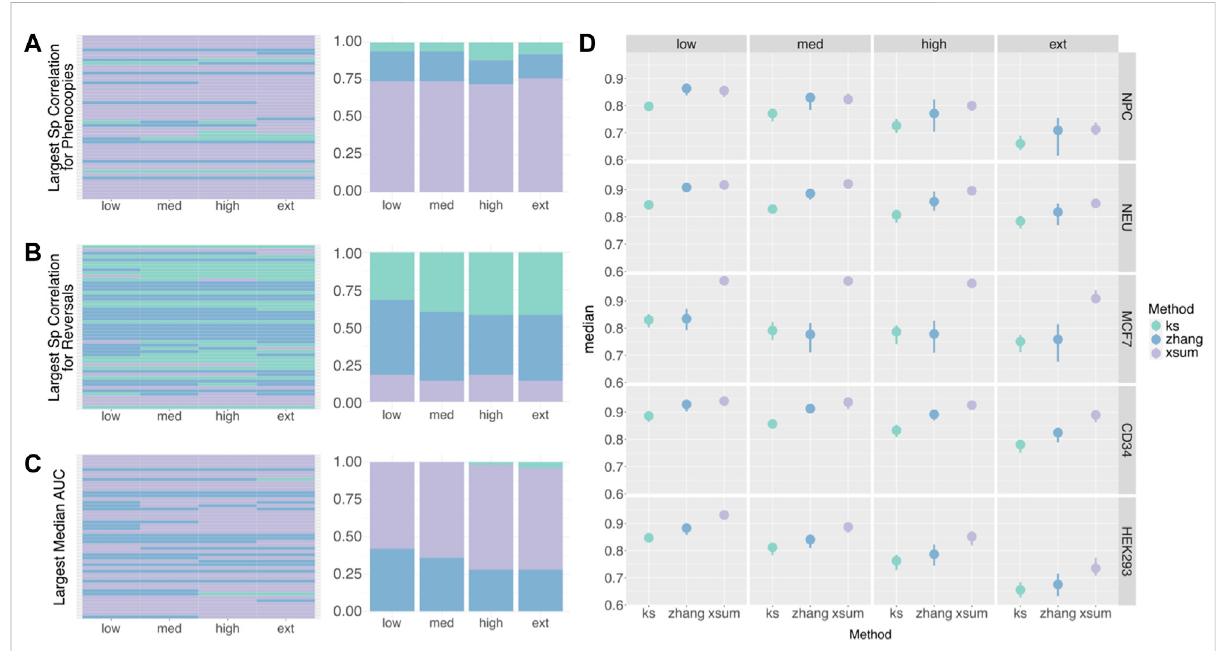
FIGURE 5 Spearman Correlation of Simulated Signature Ranks. (A) Heatmap (left) and proportion plot (right) indicating the method that attained the largest median correlation for phenocopy signature ranks. The rows of the heatmap represent the randSig s that were selected for noise simulation. (B) Heatmap (left) and proportion plot (right) indicating the method that attained the largest median correlation for reversal signature ranks. (C) Heatmap (left) and proportion plot (right) indicating the method that attained the largest median AUC. (D) Point range plot of the median AUC (n = 50) between the actual and predicted signi fi cance labels of randSig . The AUCs of a representative signature from each cell line was used to generate the plot. The complete plot for every randSig can be found in the Supplementary Materials. Green: KS, blue: Zhang, purple: